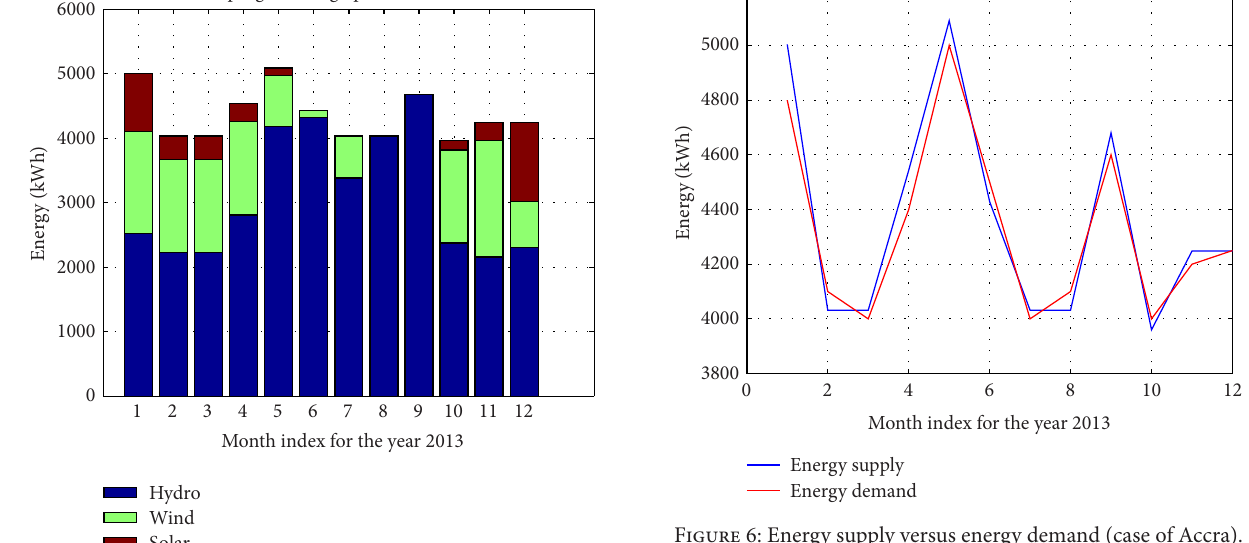
Figure 6: Energy supply versus energy demand (case of Accra).